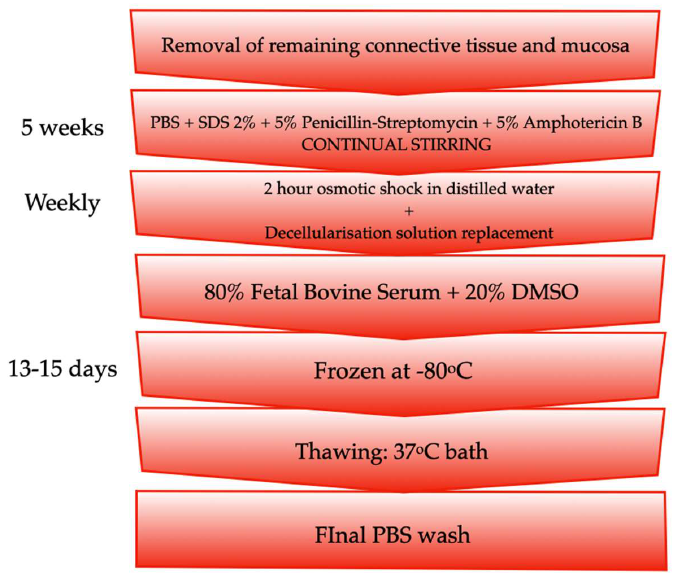
Figure 1. Flowchart of the decellularisation